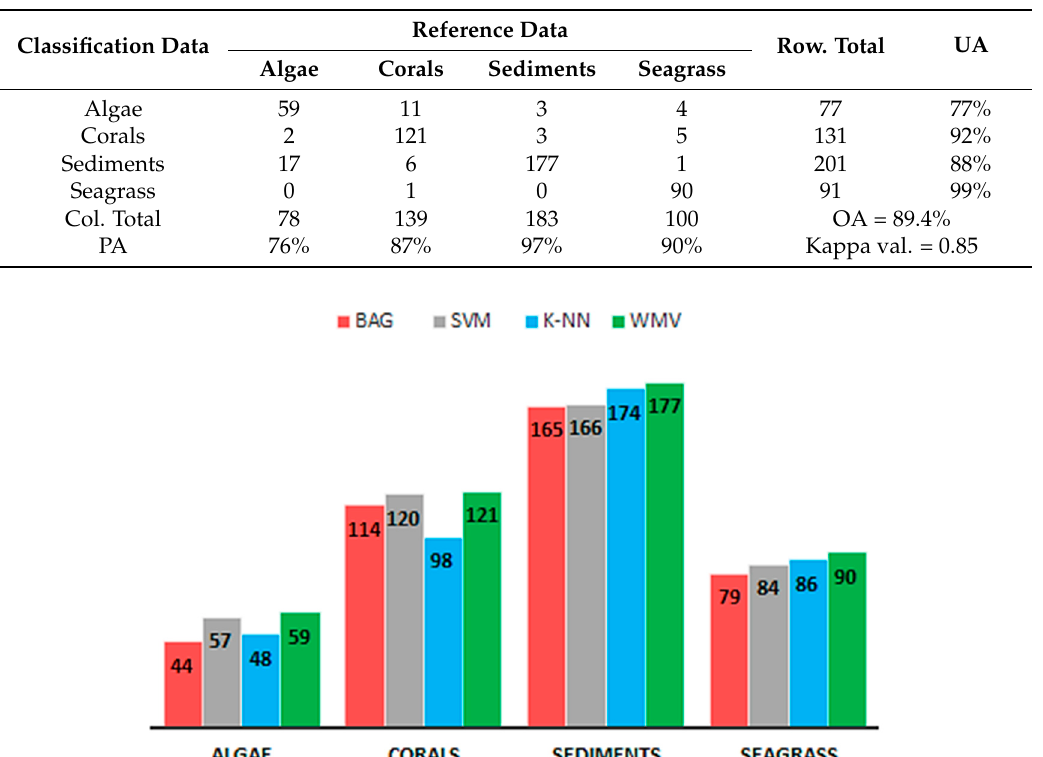
Table 2. The confusion matrix for benthic habitats detection using WMV method.